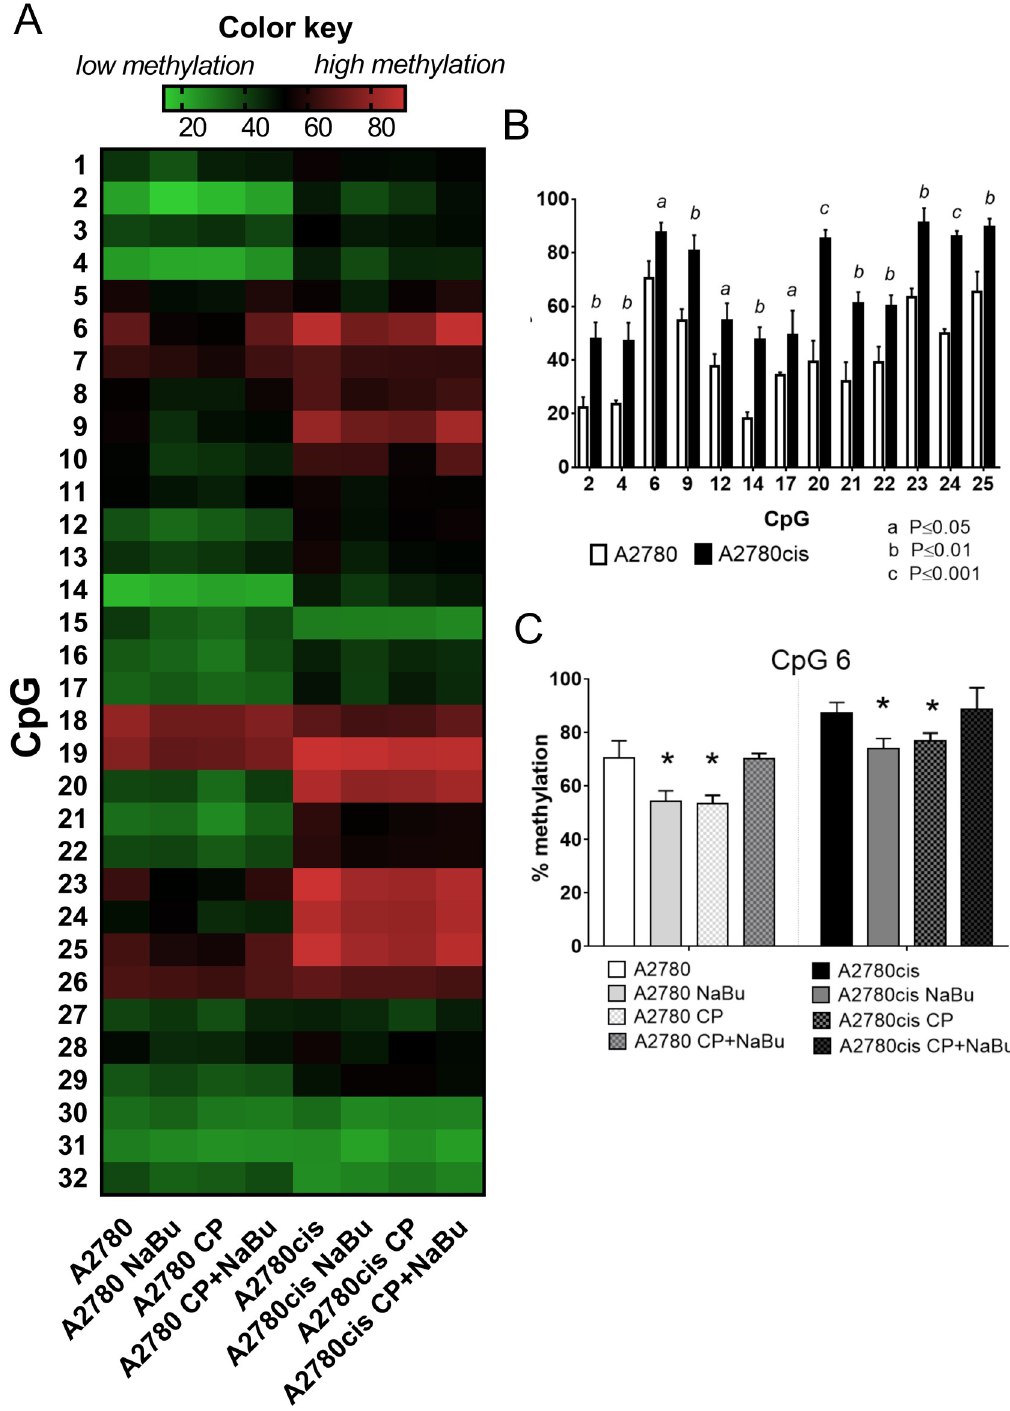
Fig 4. CDH1 gene methylation. Heat map displays changes in CDH1 methylation in 32 CpG sites in A2780 and A2780cis cells treated with NaBu, CP or combination of both (A). Analysis was performed in three independent experiments, means are shown. Significantly hypermethylated individual CpG sites in A2780cis cells compared to A2780 cells (B). The effect of NaBu, CP or combined treatment on percentage of methylation at CpG site 6 (C). The plots represent means ± SD of 3 independent experiments. Significance was tested using Student t-test P �